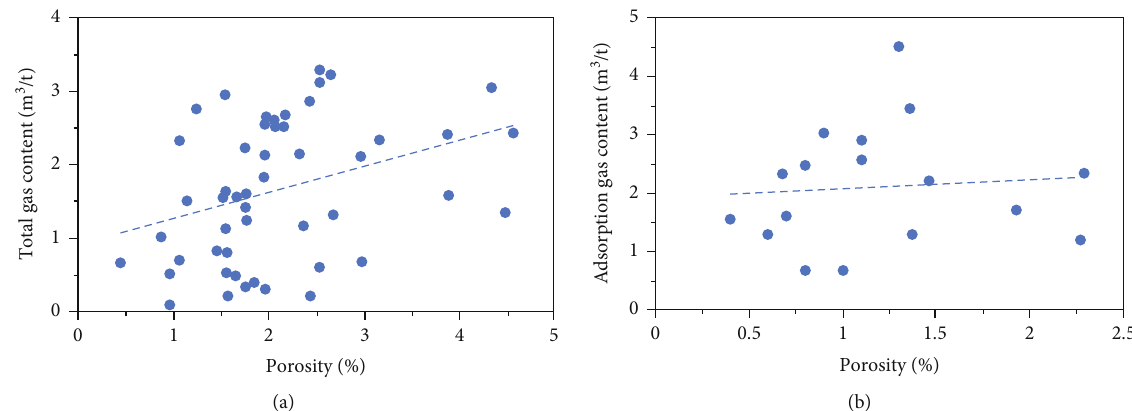
Figure 13: Cross-plots of porosity versus (a) total gas content of the Lower Cambrian shales in western Hubei and (b) adsorbed gas content of the Lower Cambrian shales in northeasernt Chongqing (data from Luo et al., [44]; Ma et al.,